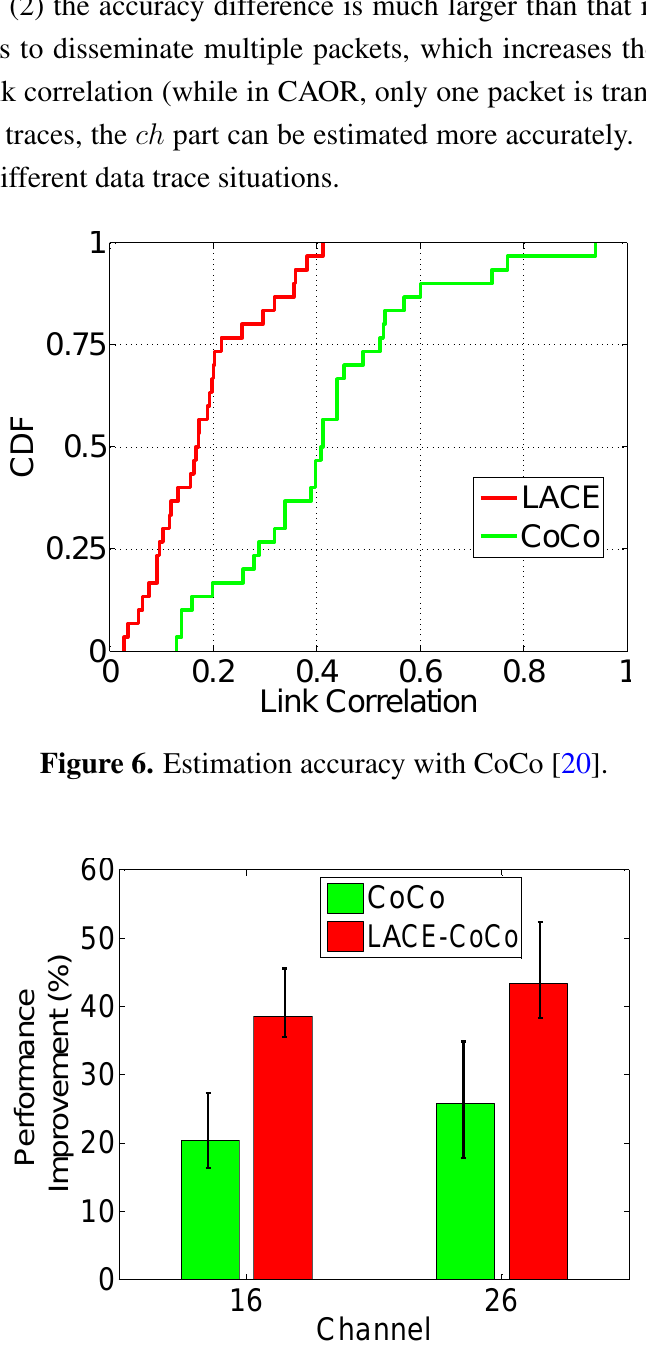
Figure 7. Performance evaluation with CoCo